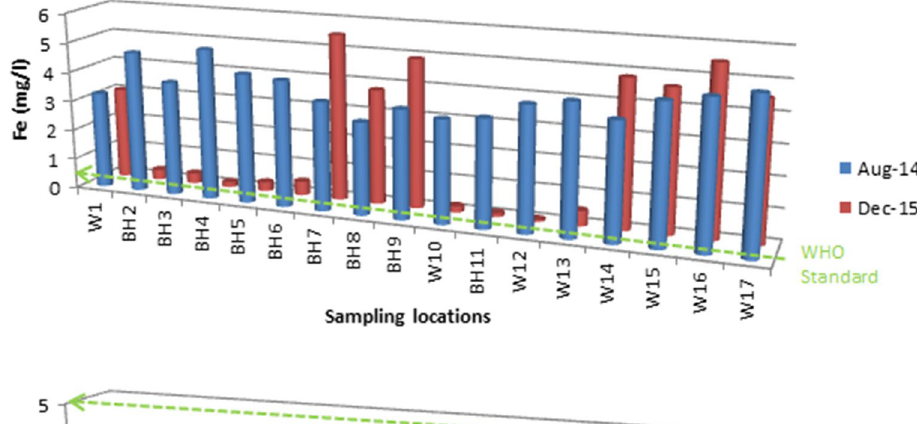
Fig. 14 Seasonal variations in Zn concentration of water sample versus WHO standard around the Olusosun dumpsite